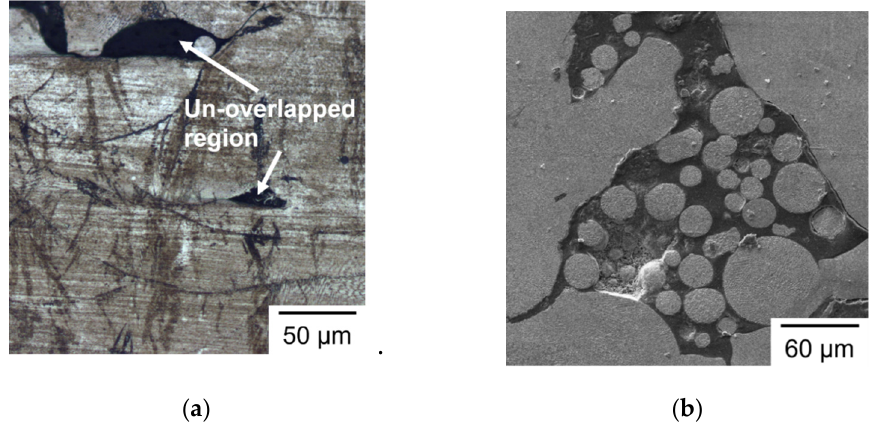
Figure 9. Micrographs of typical pores observed in ( a ) S3 (OM) and ( b ) S4 (SEM).